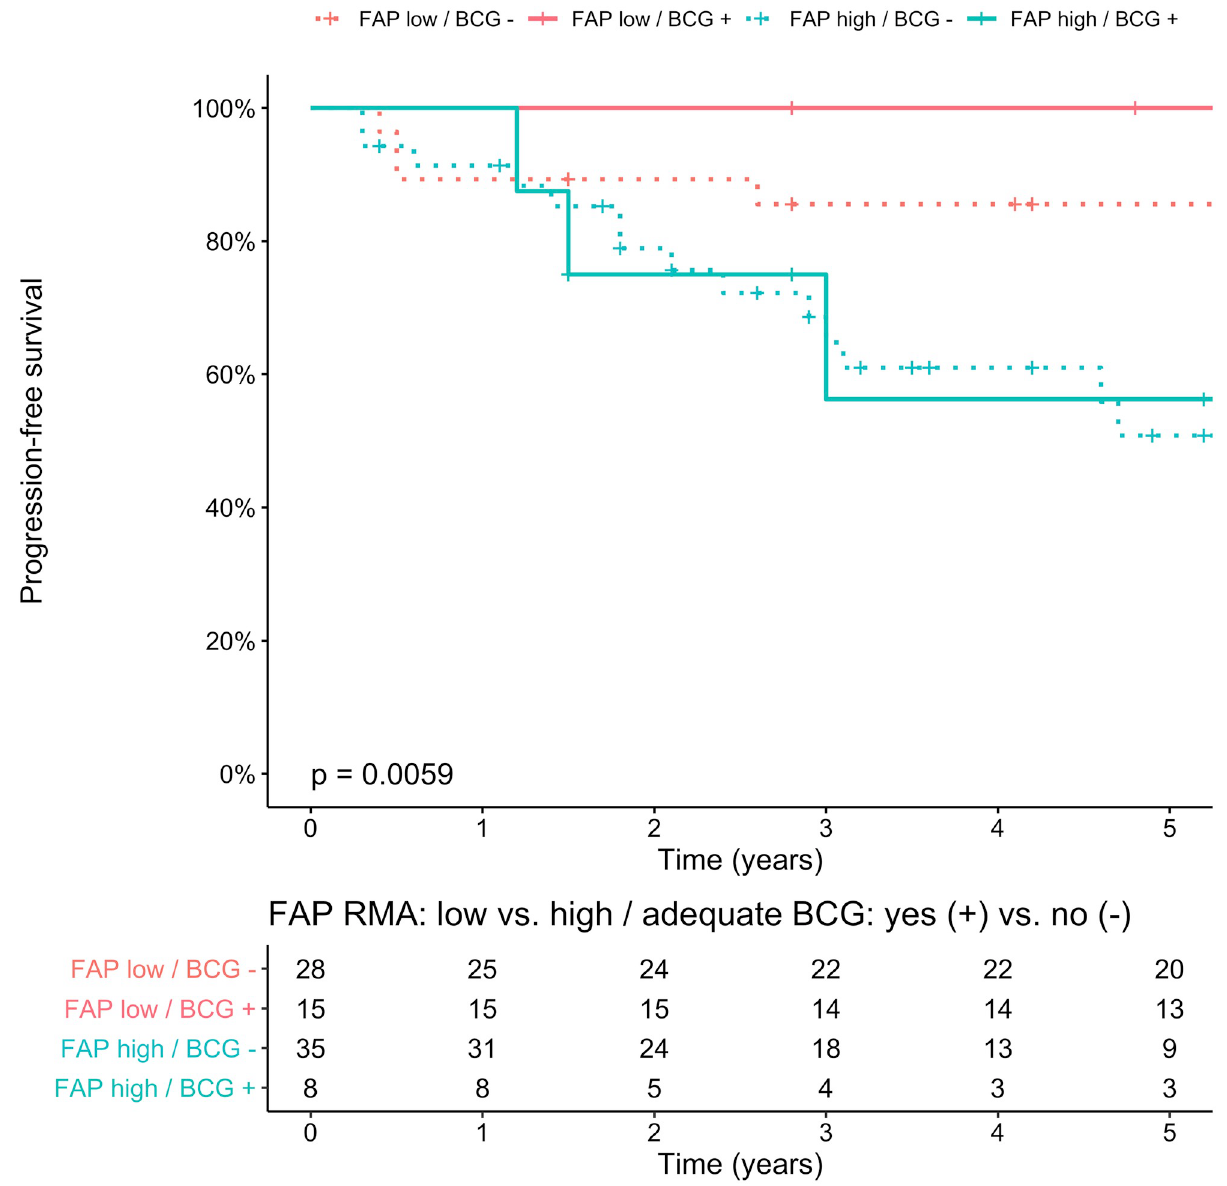
Fig 3. Kaplan-Meier plot of progression-free survival (PFS) stratified by FAP expression as relative marker area (RMA) (low [ � median] vs. high [ > median]) in T1 regions of interest, and adequate BCG (as defined by FDA; yes vs. no). Four groups are visualized: FAP low with inadequate BCG (n = 28), FAP low with adequate BCG (n = 15), FAP high with inadequate BCG (n = 34), and FAP high with adequate BCG (n = 8). All patients received al least By performing a pairwise comparison between groups using log-rank corrected by Bonferroni for multiple testing, we identified significant differences in PFS between: 1. FAP low with adequate BCG vs . FAP high with inadequate BCG (p = 0.02), and 2. FAP low with adequate BCG vs . FAP high with adequate BCG (p = 0.04). However, no significant differences were found between 1. FAP low with adequate BCG vs . FAP low with inadequate BCG (p = 0.5), and 2. FAP high with adequate BCG vs . FAP high with inadequate BCG (p =